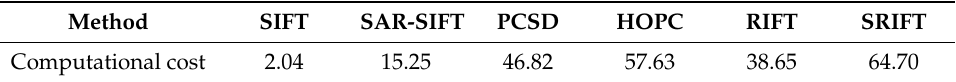
Table 4. Computational cost comparisons